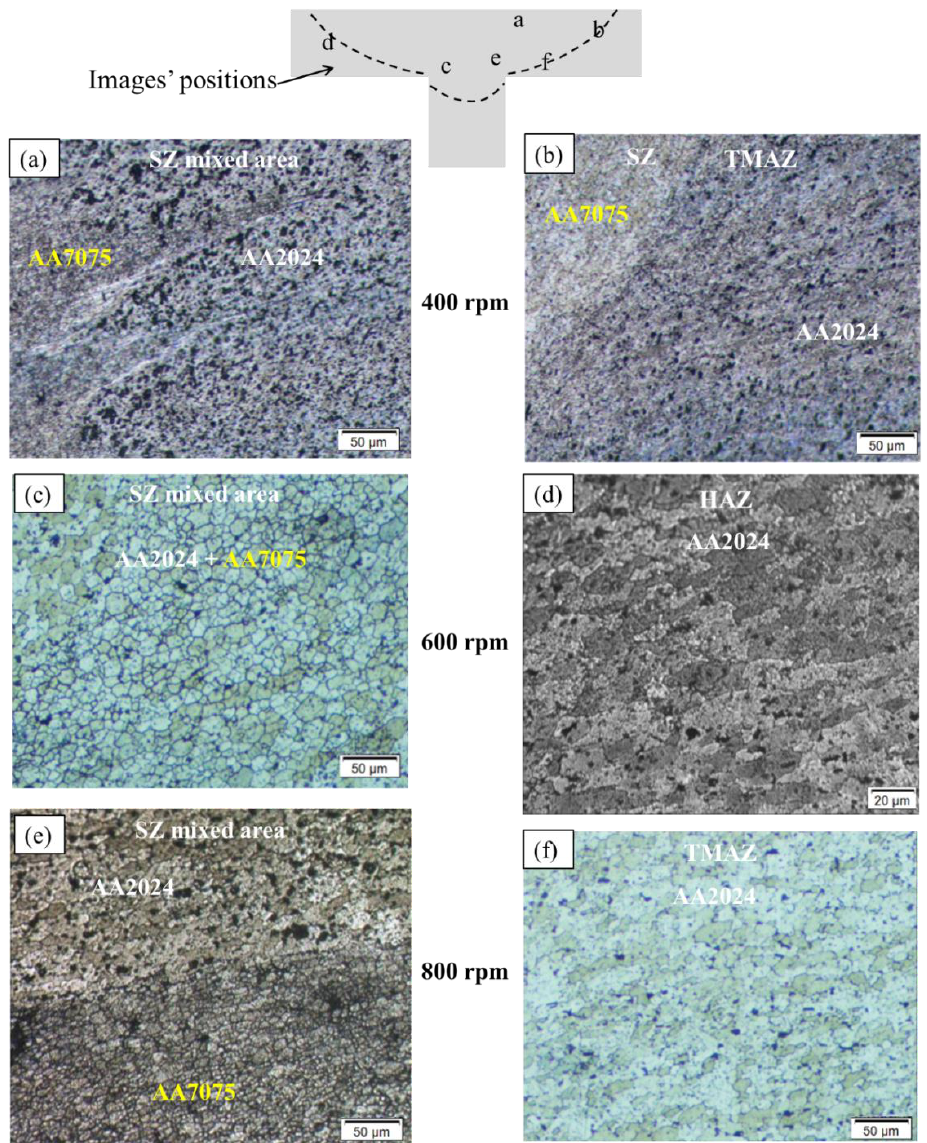
Figure 6. Optical microstructures of AA2024-AA7075 T-butt joint welded at different rotational speeds of ( a , b ) 400, ( c , d ) 600 and ( e , f ) 800 rpm. The positions of the different images are shown in the top schematic